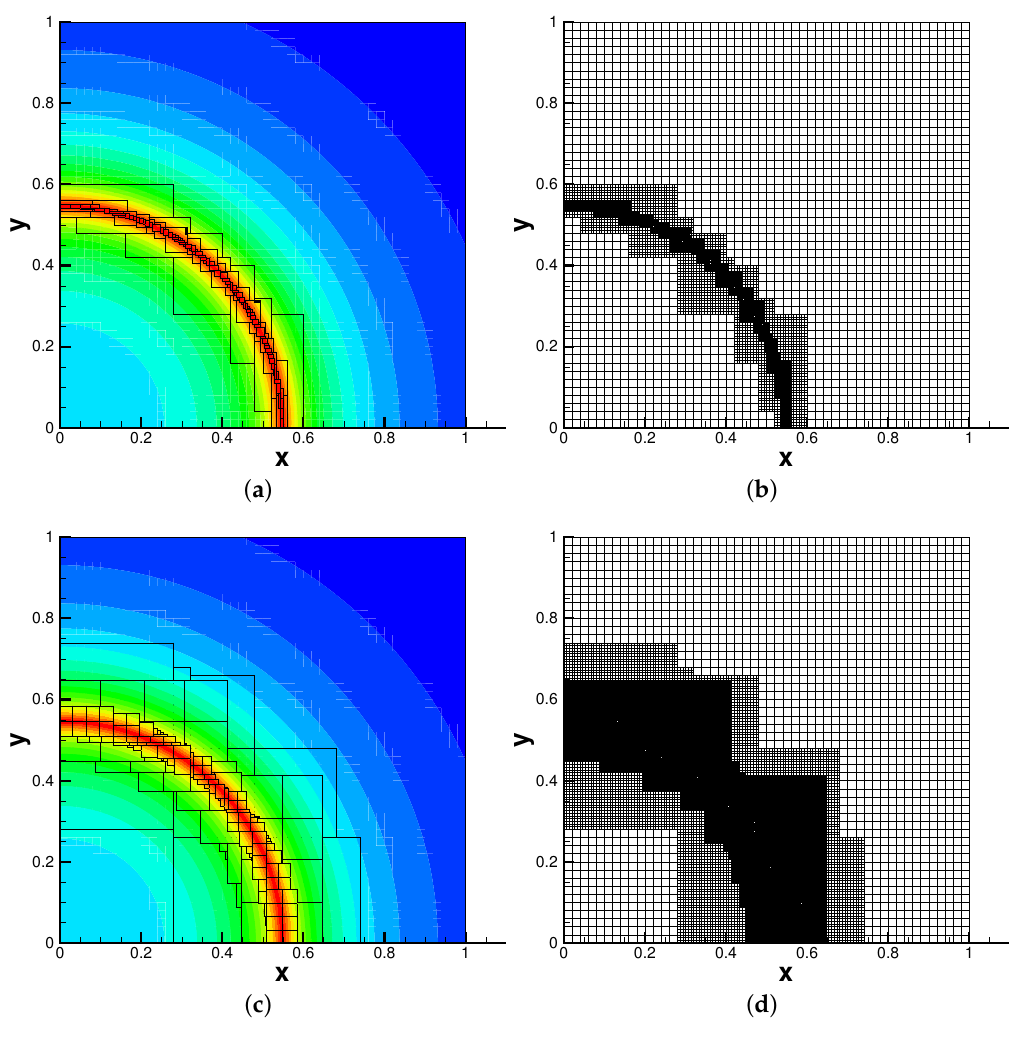
Figure 4. Interpolation comparison of f 1 using the WENO reconstruction. ( a ) interpolant function of f 1 with (cid:101) = 10; ( b ) AMR mesh with (cid:101) = 10; ( c ) interpolant function of f 1 with (cid:101) = 1; ( d ) AMR mesh with (cid:101) =